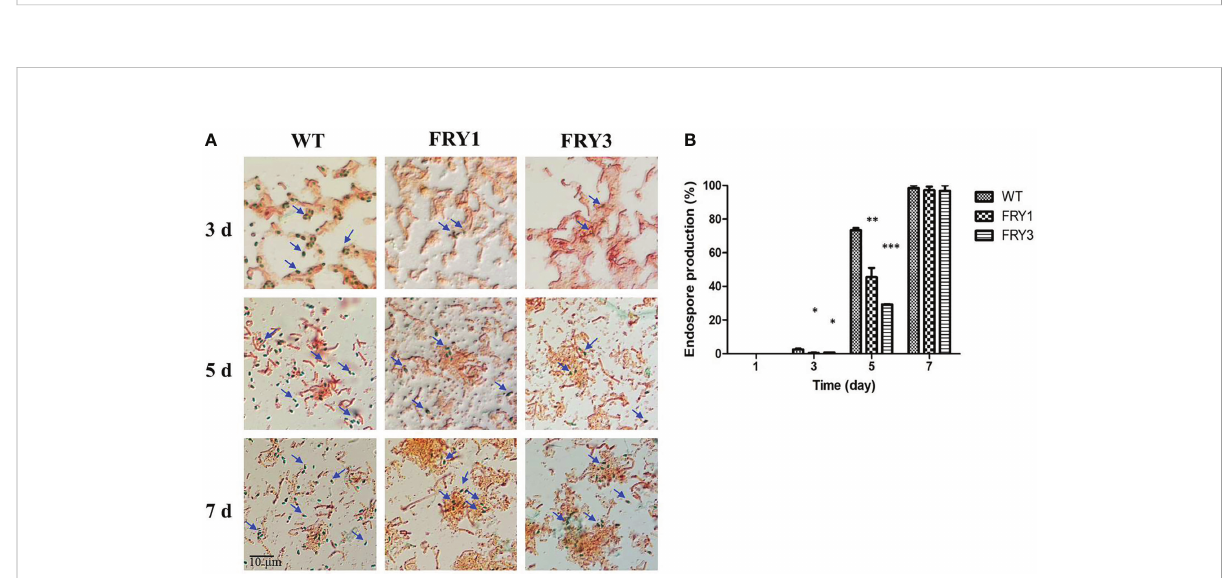
FIGURE 6 The endospore formation of D srf mutants was decreased. (A) Endospores were stained and observed under a microscope (100×). (B) Graph of endospore formation. The strains were treated at 80°C for 10 min to kill vegetative cells and plated on LB agar to calculate the number of endospores. Endospore formation was the ratio of endospore numbers divided by total colony numbers. P values were calculated by t -test, “ * ” , “ ** ” and “ *** ” represent P < 0.05, P < 0.01 and P < 0.001 respectively as compared to the